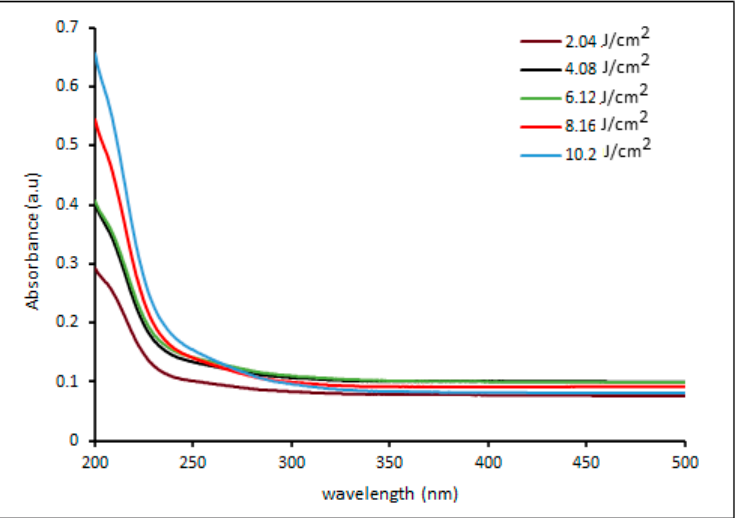
Figure 6. UV-vis absorbance spectra of palladium NPs colloidal prepared by pulsed laser ablation of palladium target in DI water with different laser fluences.